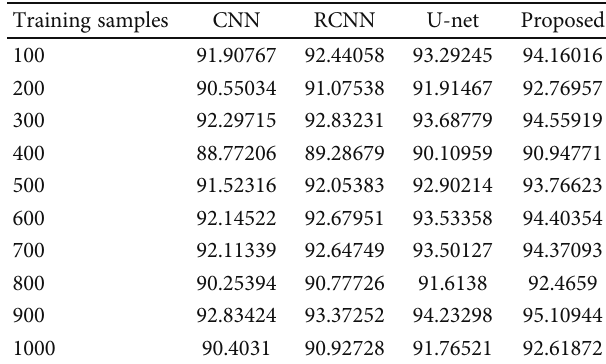
Table 1: Accuracy of Prediction.